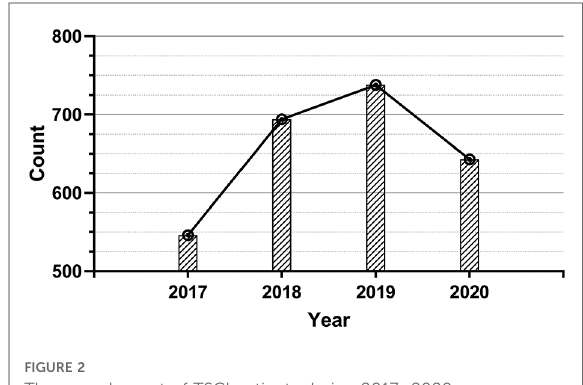
FIGURE 2 The annual count of TSCI patients during 2017 –